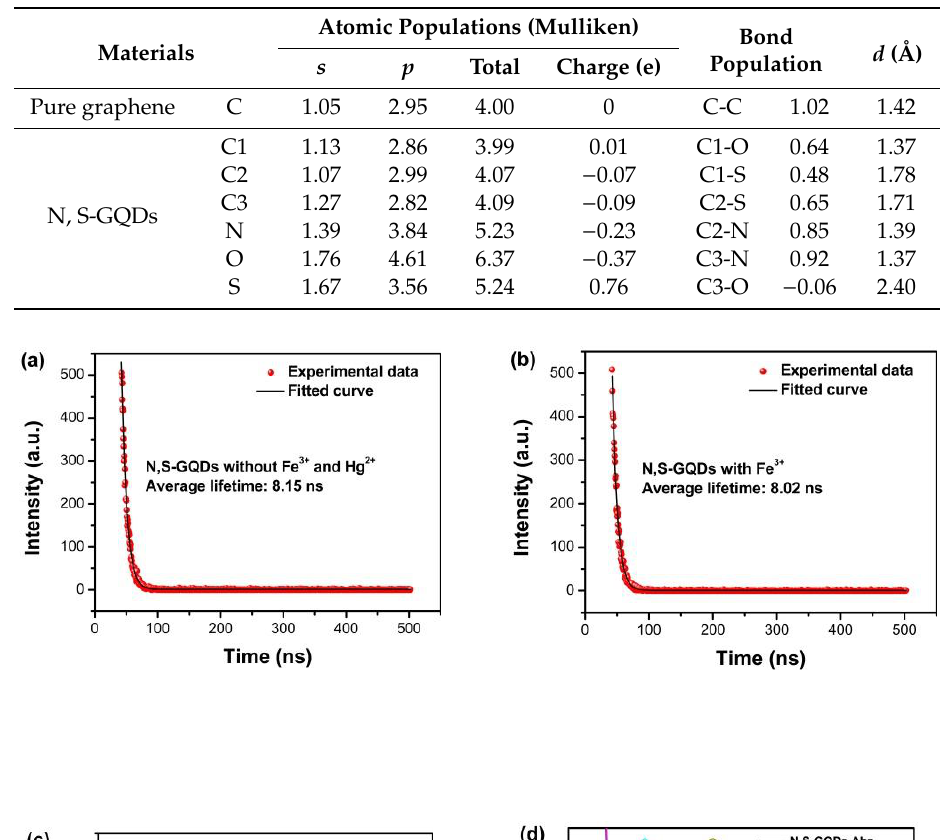
Table 1. The atomic populations of pure graphene and N, S-GQDs. Materials